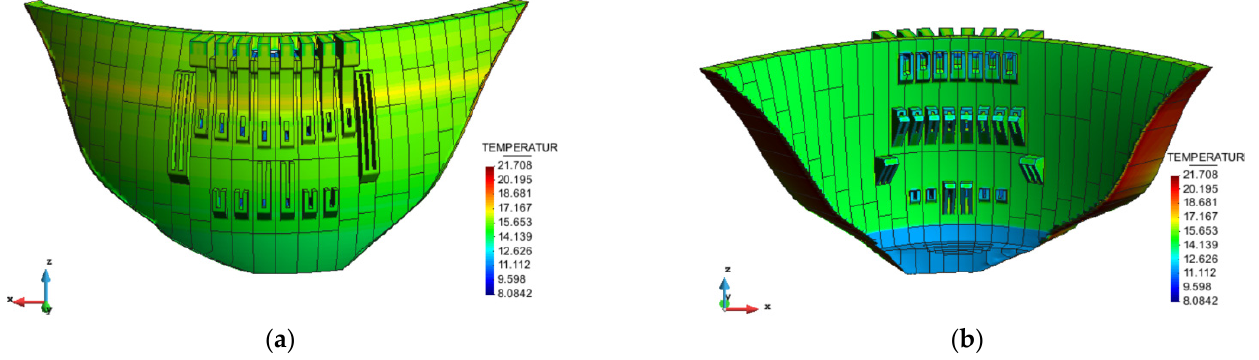
Figure 15. Cloud map of quasi-stable temperature field distribution of the dam in January (unit: °C). ( a ) Upstream face; ( b ) Downstream